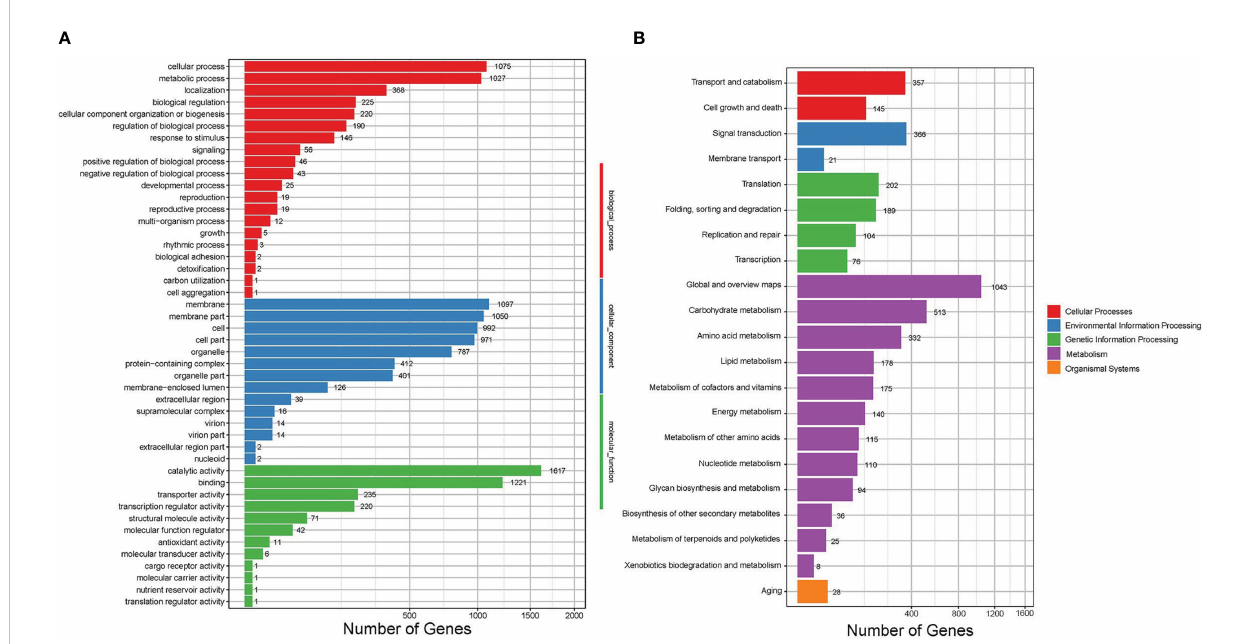
FIGURE 5 GO function and KEGG pathway enrichment analyses for DEGs of Sarocladium terricola cultured in two types of media. (A) GO analysis, (B) KEGG analysis. Differentially expressed genes were classi fi ed into biological process, cellular component, and molecular function categories in the GO analysis, and cellular processes, environmental information processing, genetic information processing, metabolism and organismal systems in the KEGG